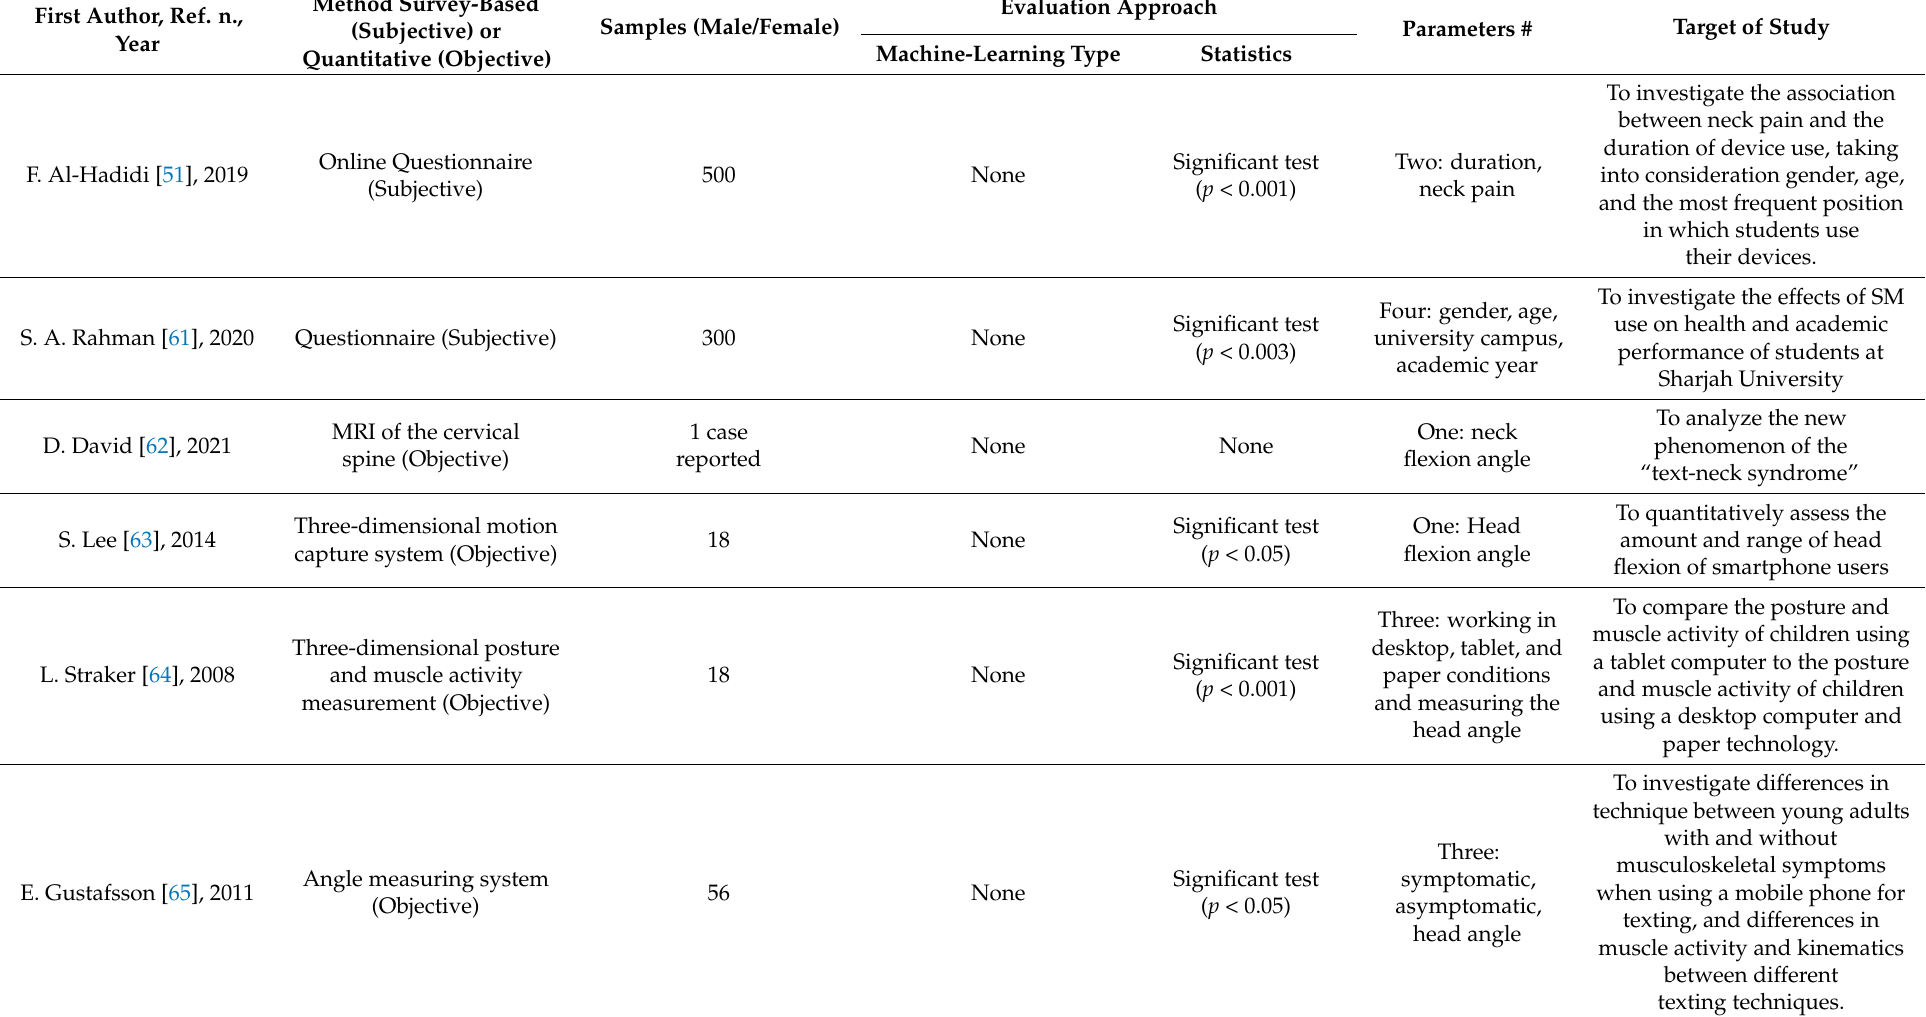
Table 11. Comparison of this work with similar scientific works reported in the literature analyzing the impact of using the SM devices on neck-pain occurrence. First Author, Ref.